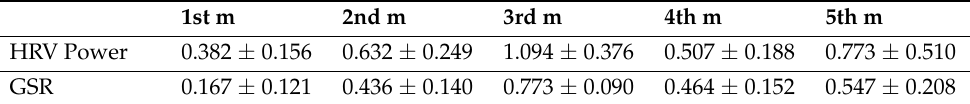
Figure 12. Experiment 1 Box plot for Growth rate HRV power and GSR. Table 5. Mean and standard deviation of Experiment 1 with respect to time (minutes).